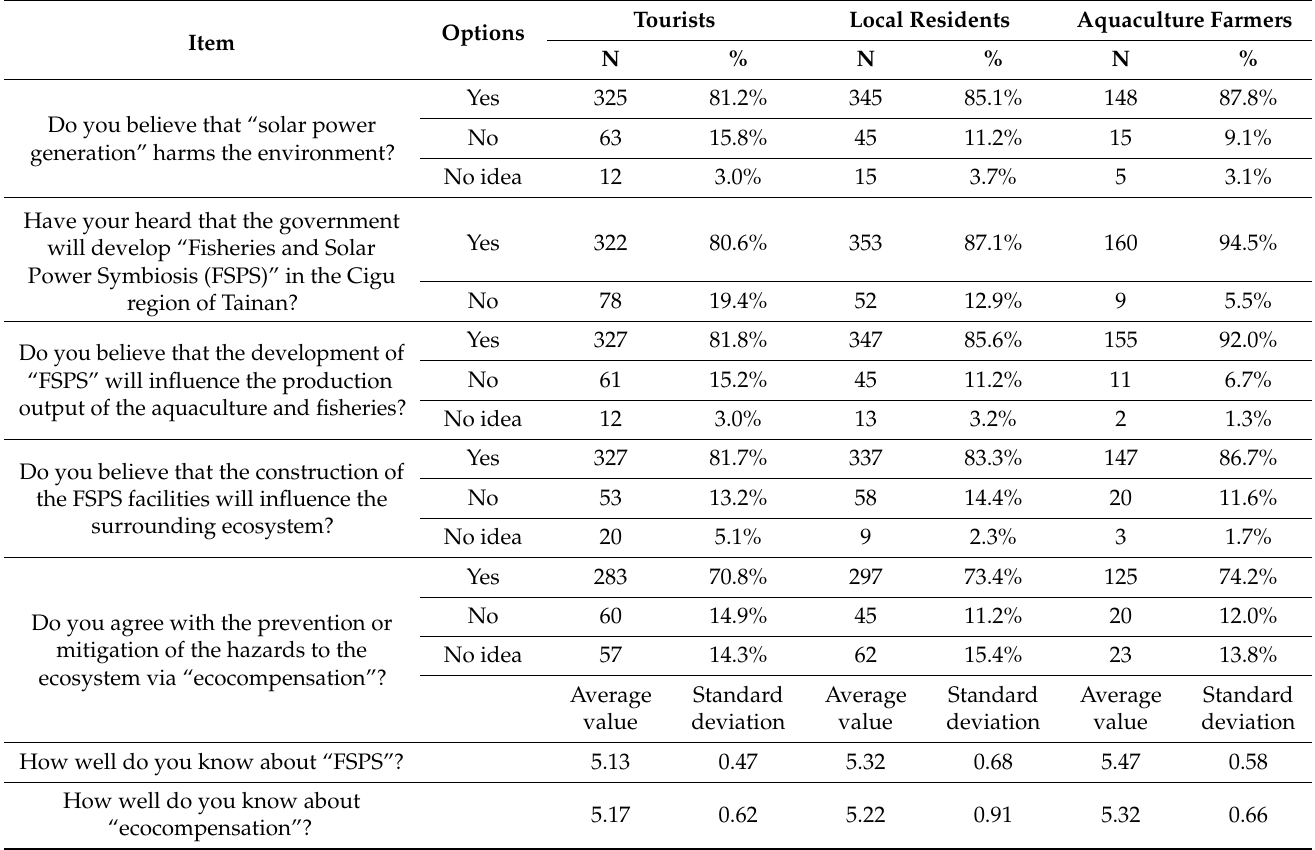
Table 4. Respondents’ ecological knowledge and preferences for ecosystem